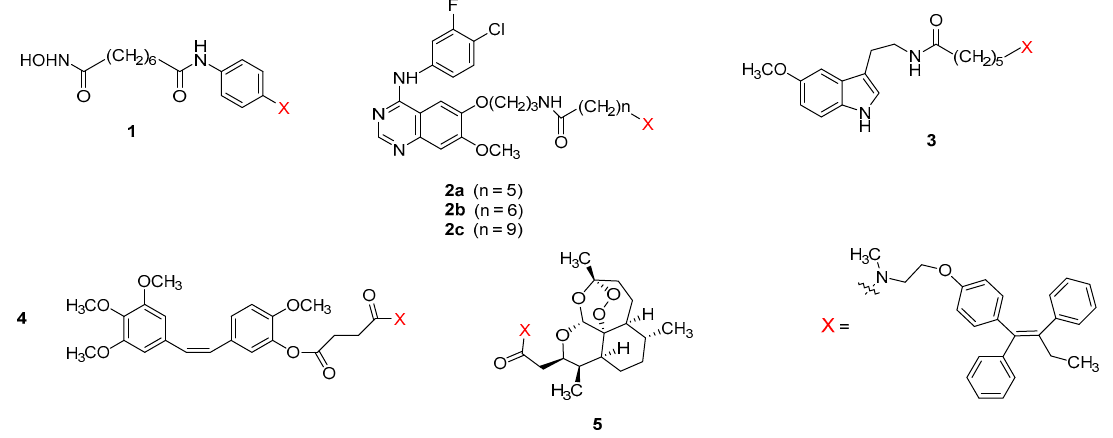
Figure 2. Structures of selected drug conjugates incorporating tamoxifen. Table 1. Pharmacological actions of drug conjugates incorporating